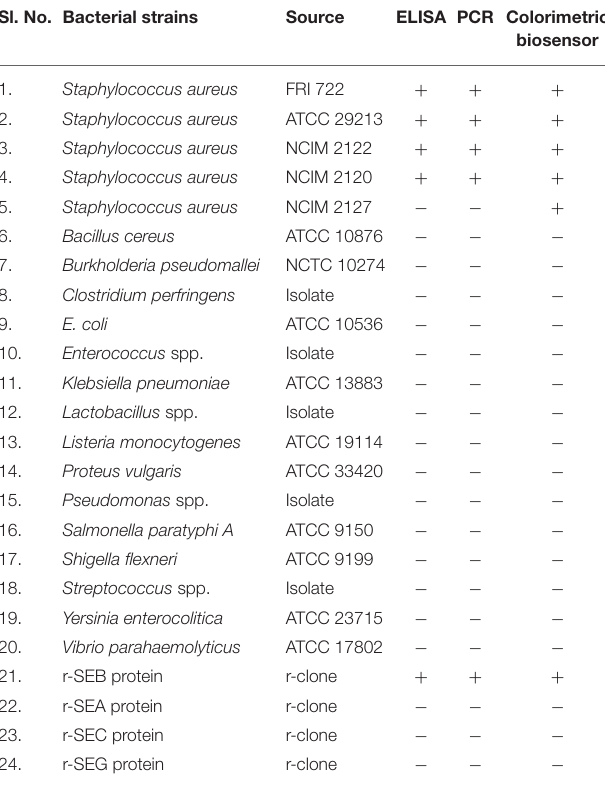
TABLE 1 | List of bacterial strains and r-protein used in the study. Sl. No. Bacterial